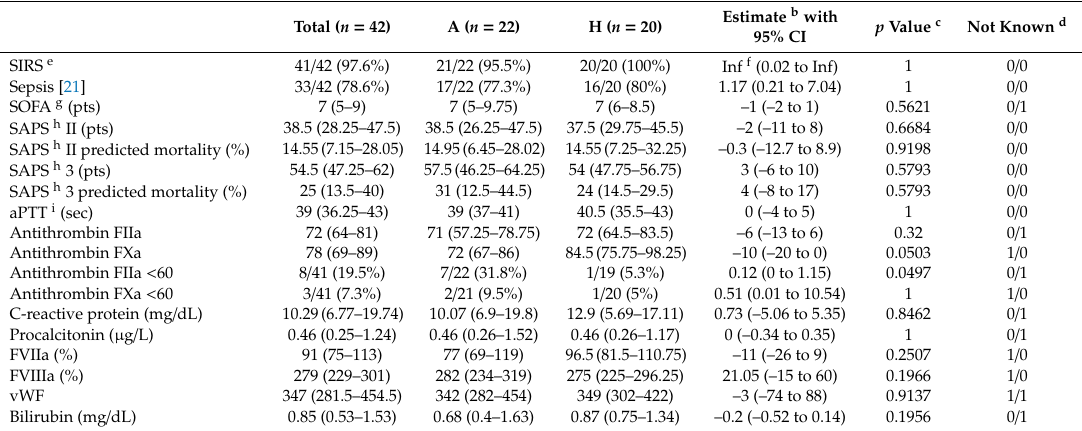
Table 2. Disease severity and baseline laboratory values